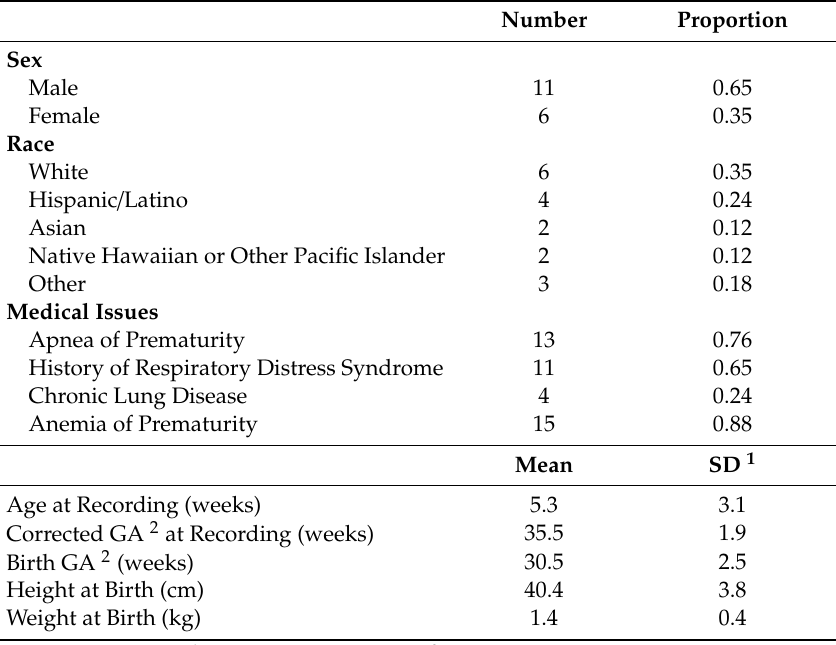
Table 1. Demographics of enrolled